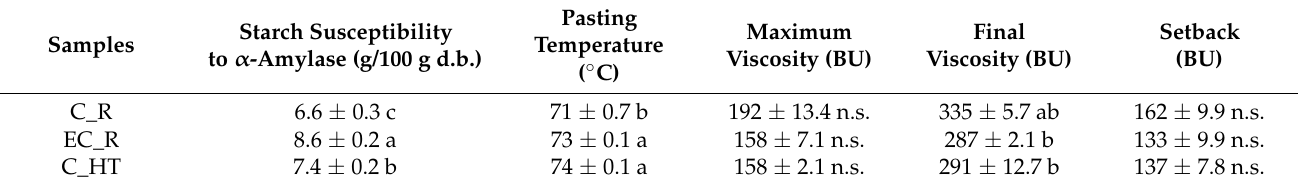
Table 1. Starch susceptibility to α -amylase and pasting properties of pasta from red lentils. Starch Susceptibility Samples to α -Amylase (g/100 g d.b.)